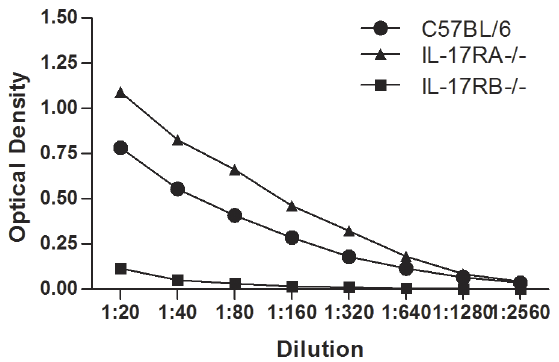
Figure 5. H.pylori -specific IgG1is reduced in IL-17RB deficient mice during H.pylori infection. Isotype antibodies specific for H. pylori (strain SS1) were quantitated by enzyme-linked immunosorbent assay (ELISA). Levels of H. pylori - specific IgG1 in the serum from SS1 infected mice were measured at 3 months post infection. 9–10 mice (independent serum samples) were used for each mouse group.